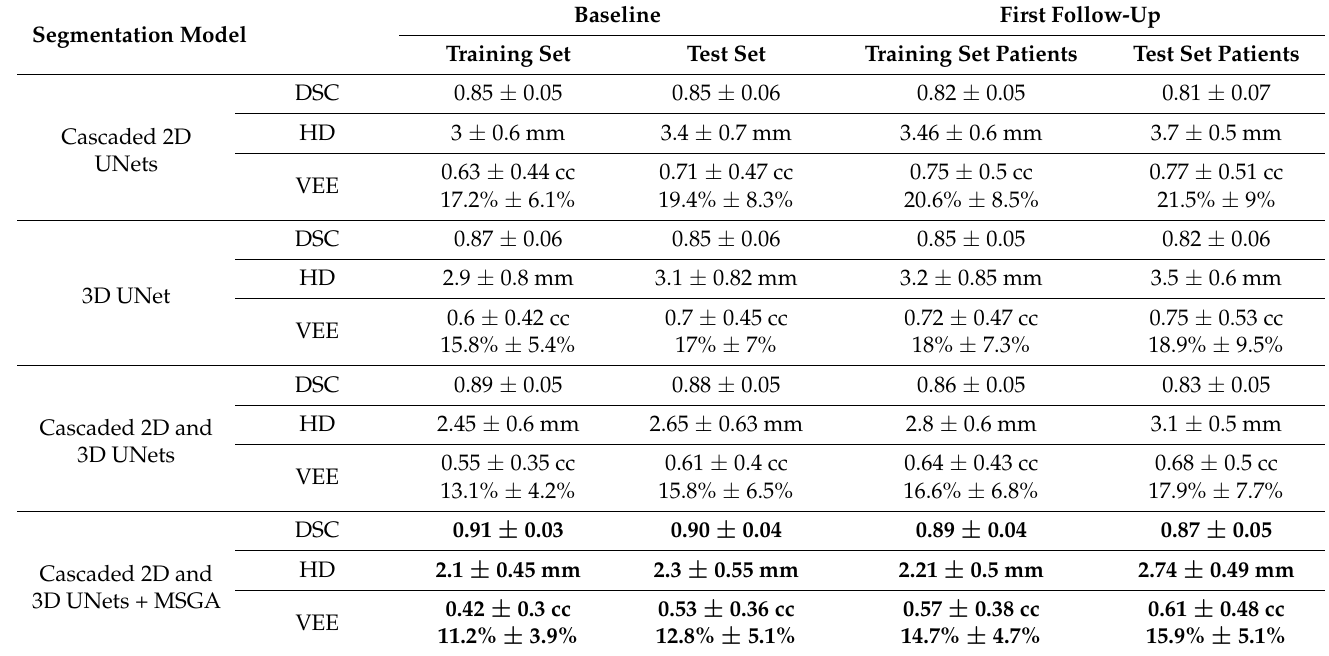
Table 1. Dice similarity coefficient (DSC), Hausdorff distance (HD), and volume estimation error (VEE) for segmentation of brain metastasis using different network architectures. The best values in each column are shown in